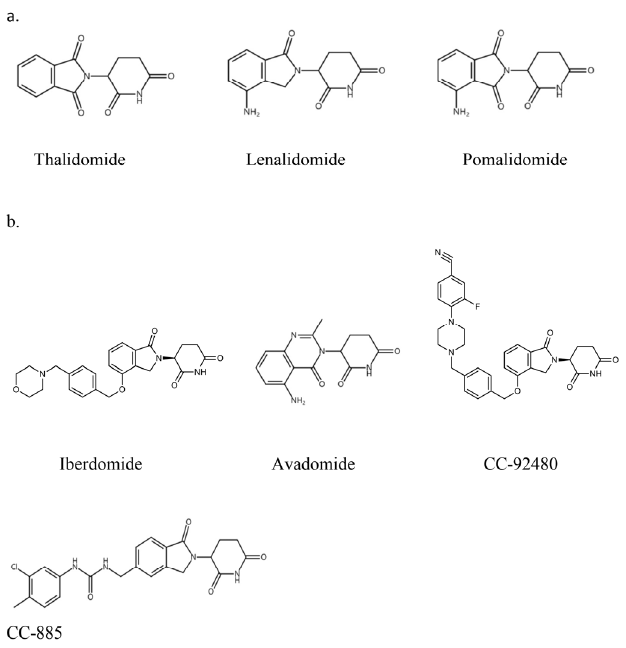
Figure 1. Chemical structure of immunomodulatory drugs ( a ) and Cereblon E3 ligase modulators ( b ).